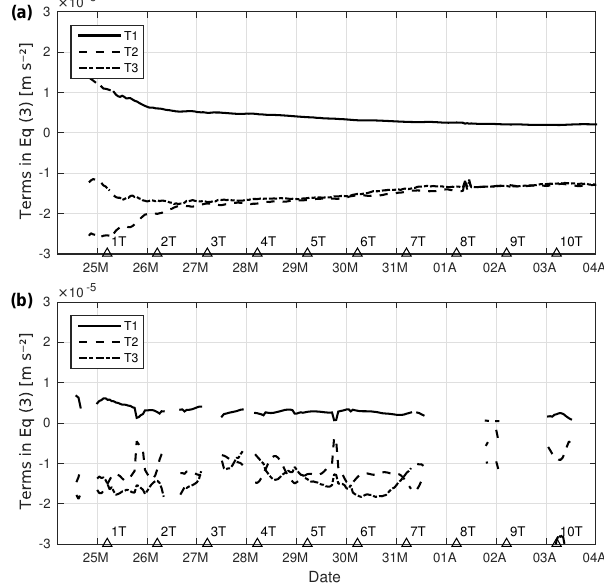
Figure 9. Time series of spatially averaged momentum balance terms (see Eq. 3): centrifugal term ( T 1 ) (solid), Coriolis term ( T 2 ) (dashed), and pressure gradient term ( T 3 ) (dash dotted) for ideal (a) and real (b) bulges. Triangles represent the rotation period of the earth starting from 24 March 2007,